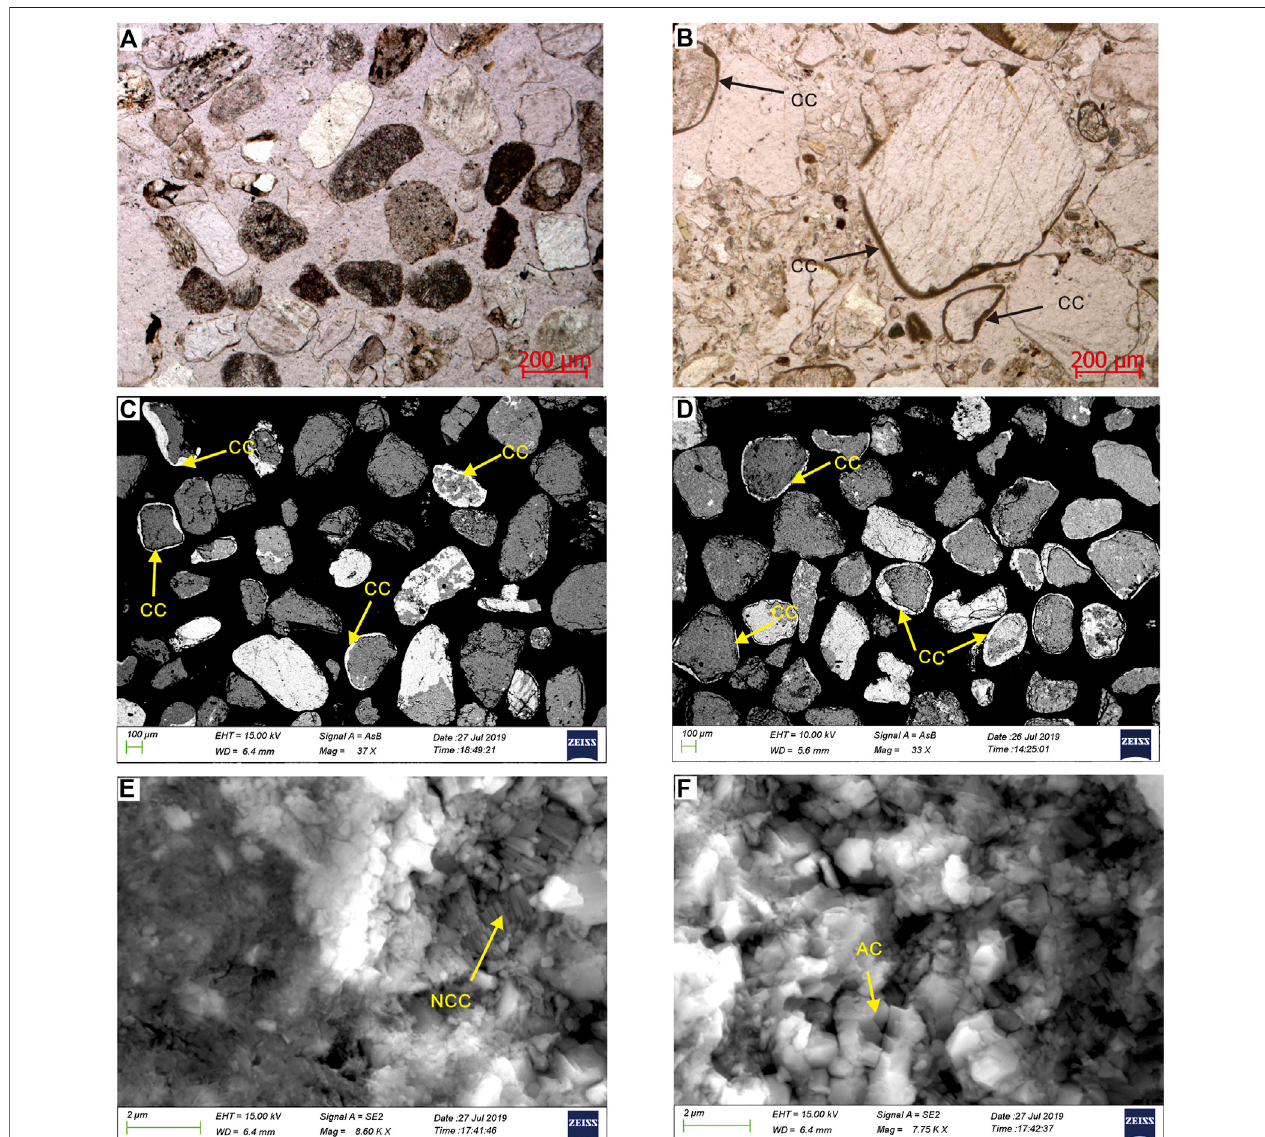
FIGURE 3 | Representative microphotographs under optical microscope and scanning electronic microscopy (SEM) showing the textural characteristics of carbonate coats within the study area. (A) Photomicrograph of the sand sediments from Buha River. (B) Photomicrograph of the sample QU4, CC-carbonate coat. (C) SEM image ofthesampleHX4. (D) SEM image ofthesample LD1. (E) SEMimage revealsneedle-columnar crystalswithinthecortices.NCC, needle-columnar crystals. (F) SEM image reveals anhedral crystals within the cortices. AC, anhedral crystals.